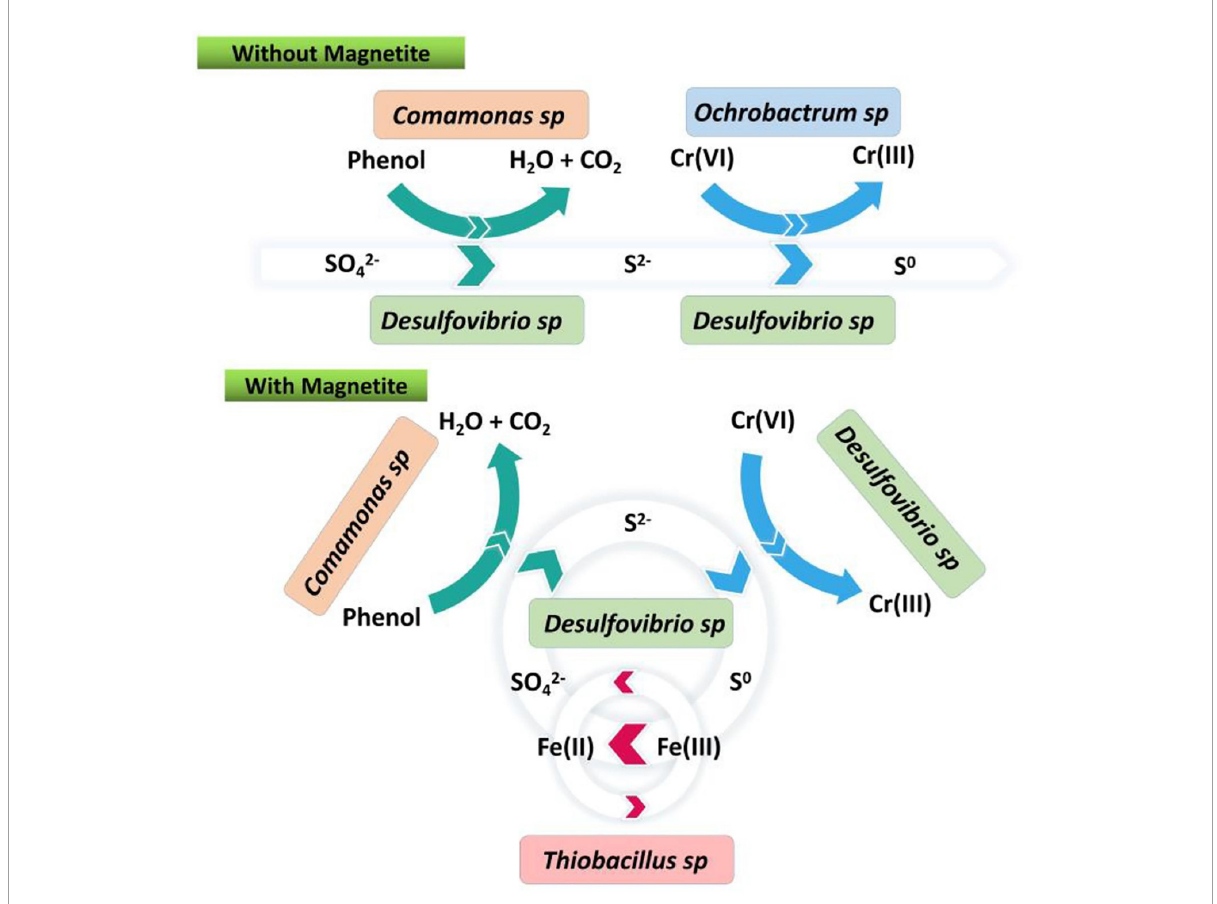
FIGURE1 Microbial sulfur cycle for phenol degradation coupled with Cr(VI) reduction via the potential Fe(III)/Fe(II) transformation (Zhao Z. Q. et al.,